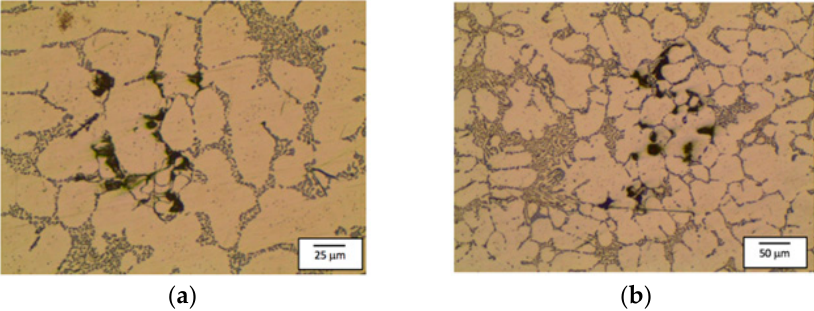
Figure 8. Optical microscopy images of Source D. ( a ) oxide bifilm in between the dendrites ( b ) pores.